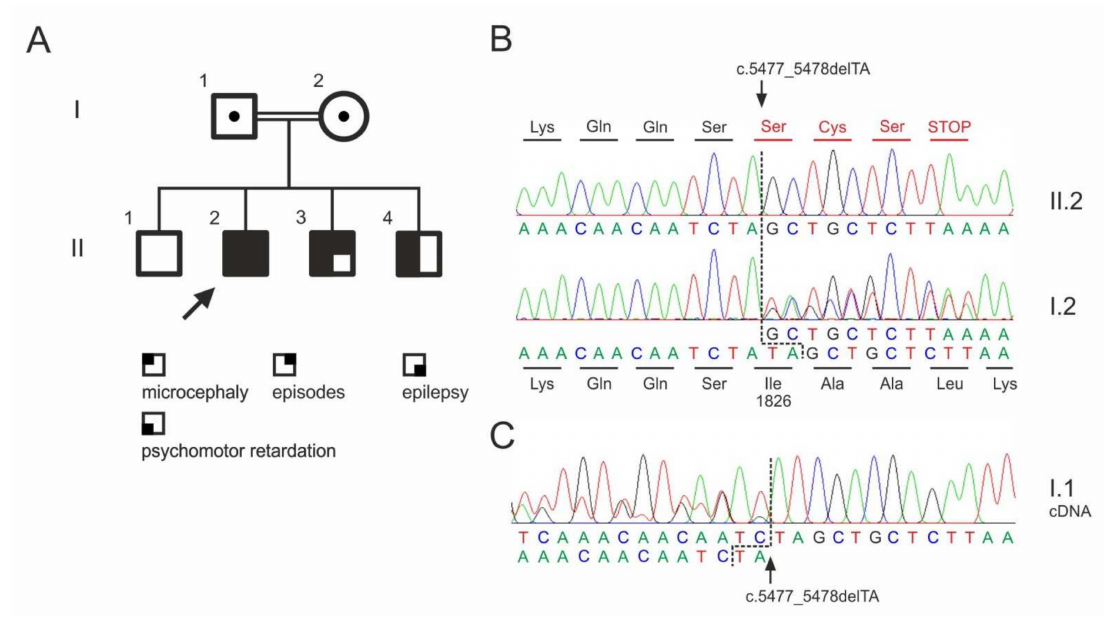
Figure 1. ASPM mutation in a consanguineous family. ( A ) Pedigree. Dots indicate heterozygous carriers. No material was available from the unaffected sibling (II.1) for genotyping. ( B ) Sequencing chromatograms of the index patient (II.2) and his unaffected mother (I.2). ( C ) Sequencing chro- matogram from cDNA obtained from whole blood RNA sample, confirming the heterozygous mutation in the father (I.1). Please note the presence of the mutant transcript in the sequencing chromatogram showing the absence of significant nonsense-mediated